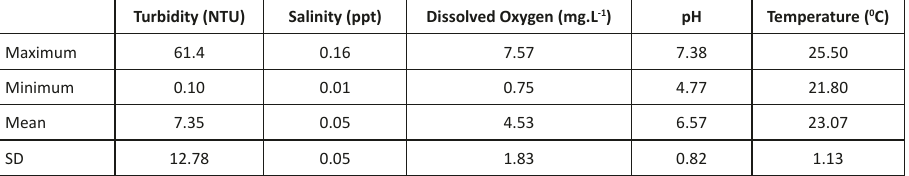
Table 1. Summary table to show range of water quality parameters from five selected sites in New Territories, Hong Kong Turbidity